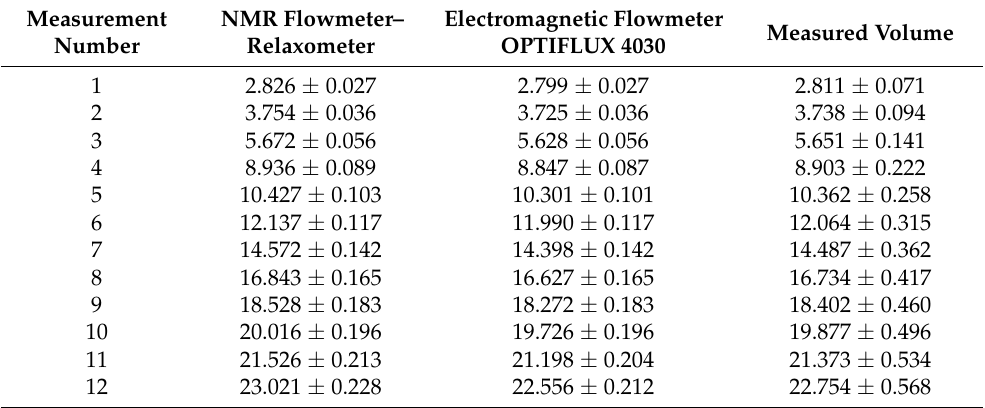
Table 1. The results of measuring the consumption q (m 3 /h) of a liquid mixture of feedwater with air bubbles and insoluble particles (with ionic conductivity (polymer) and electronic conductivity (bitumen)) at a temperature of T = 324.6 K in the pipeline of the experimental stand using various devices and a measured volume.